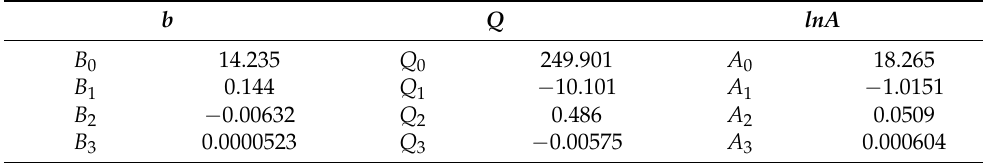
Table 5. Third-order polynomial fitting results of parameters, with strain, for the β phase Table 4. Third-order polynomial fitting results of parameters, with strain, for the α+β phase region.